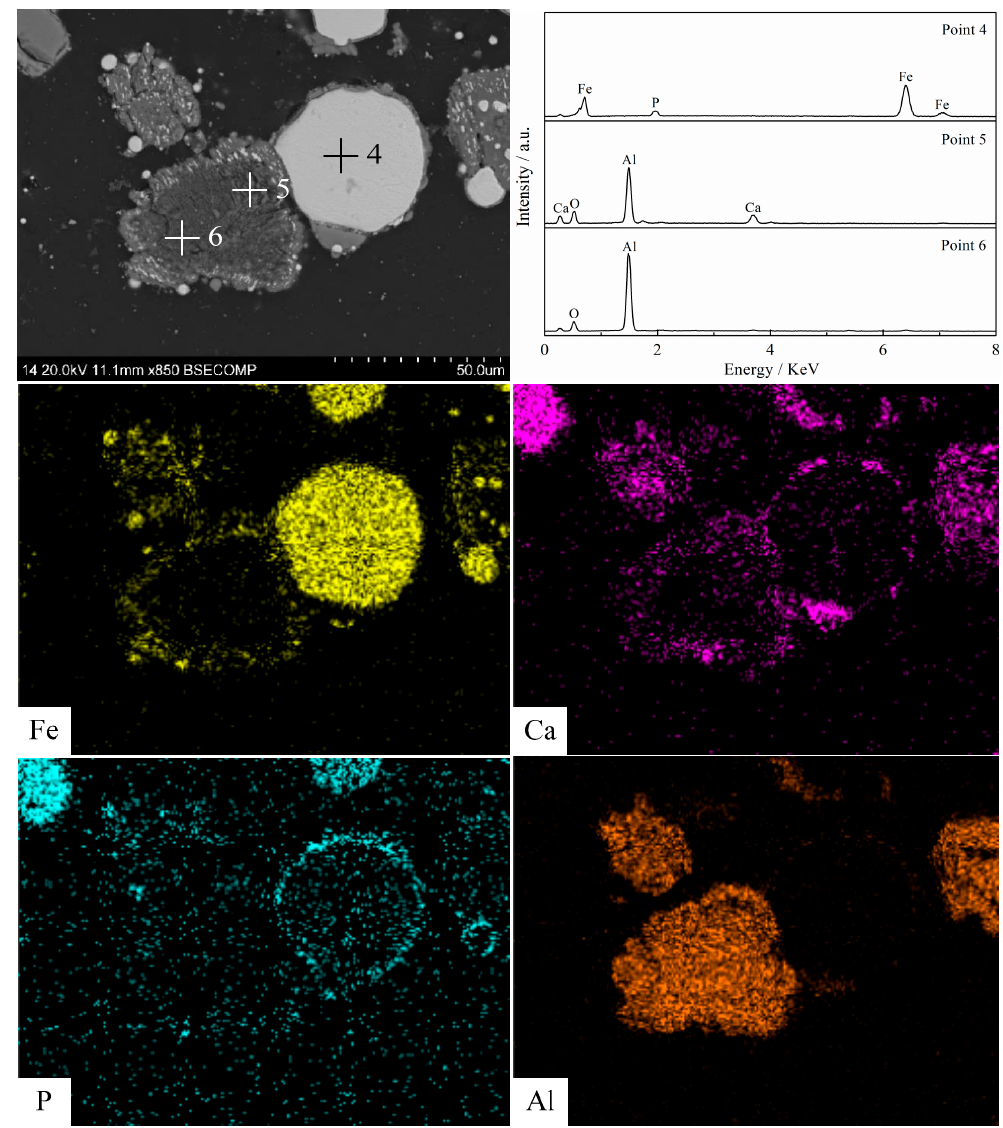
Figure 12. SEM image and EDS spectra and line-by-line scanning analysis of the reduction product in the Ca 10 (PO 4 ) 6 F 2 –Al 2 O 3 –Fe 2 O 3 –C system (reduction temperature of 1573 K and reduction time of 10 min).